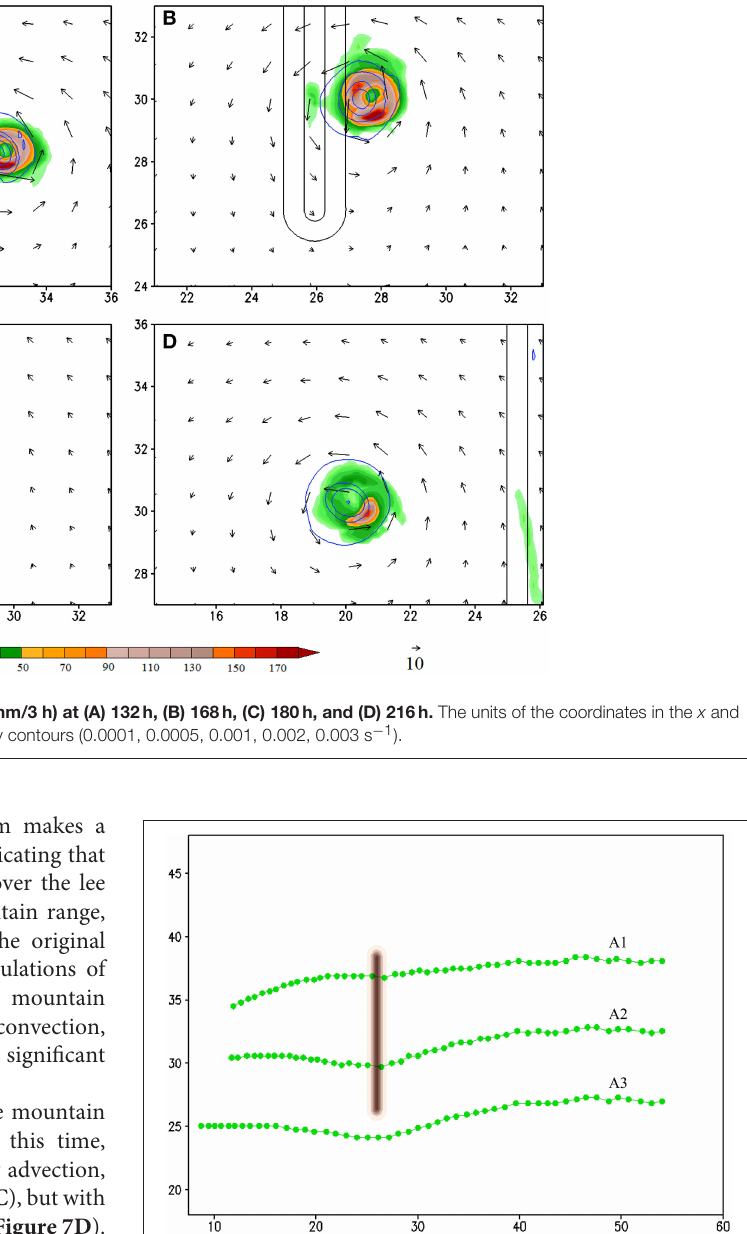
A2 (case CNTL). Figure 9 shows the simulated tracks A1,